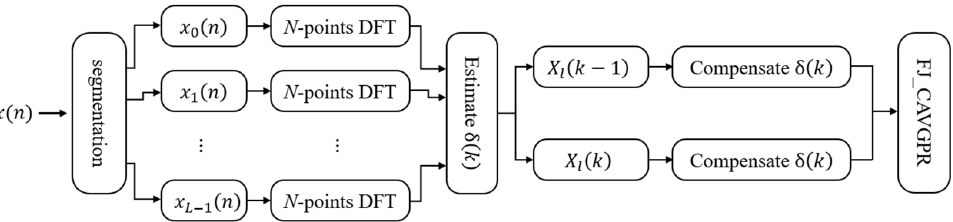
( d ) Figure 3. Detecting the four tonal signals in WGN: ( a ) AVGPR; ( b ) CGLRT; ( c ) CAPSE; ( d ) FJ_CAVGPR.